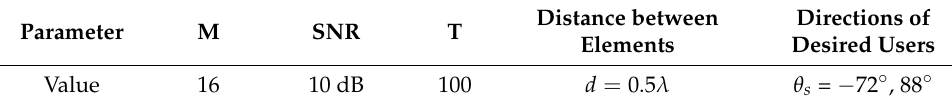
Table 5. The simulation parameters of the second scenario.